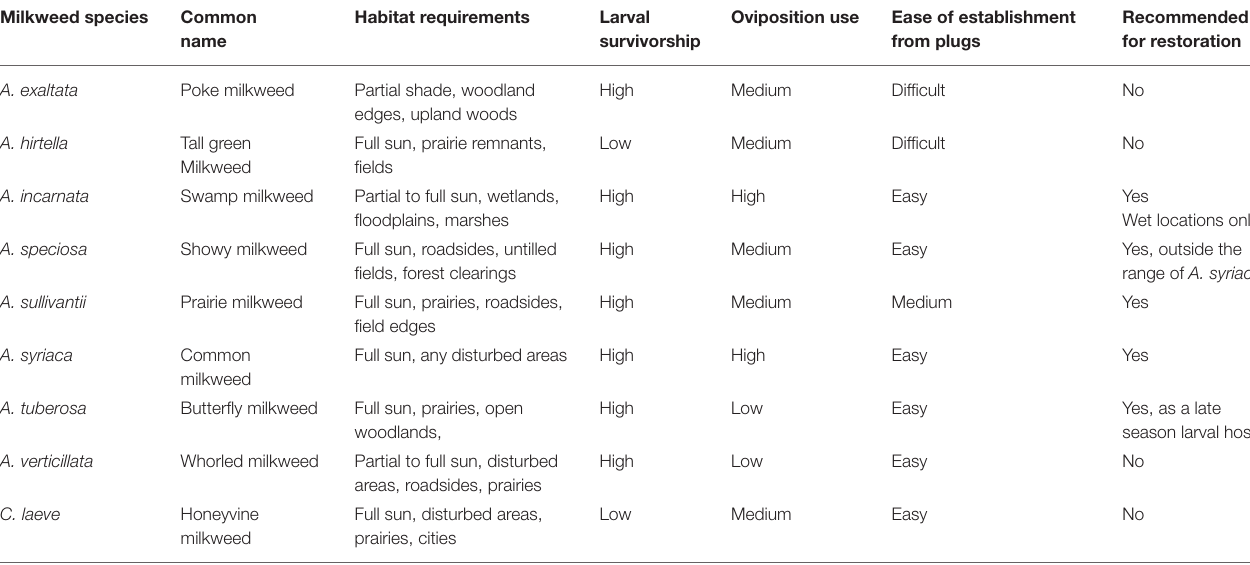
TABLE 1 | Summary of the utility of nine milkweed species examined in the current study. Milkweed